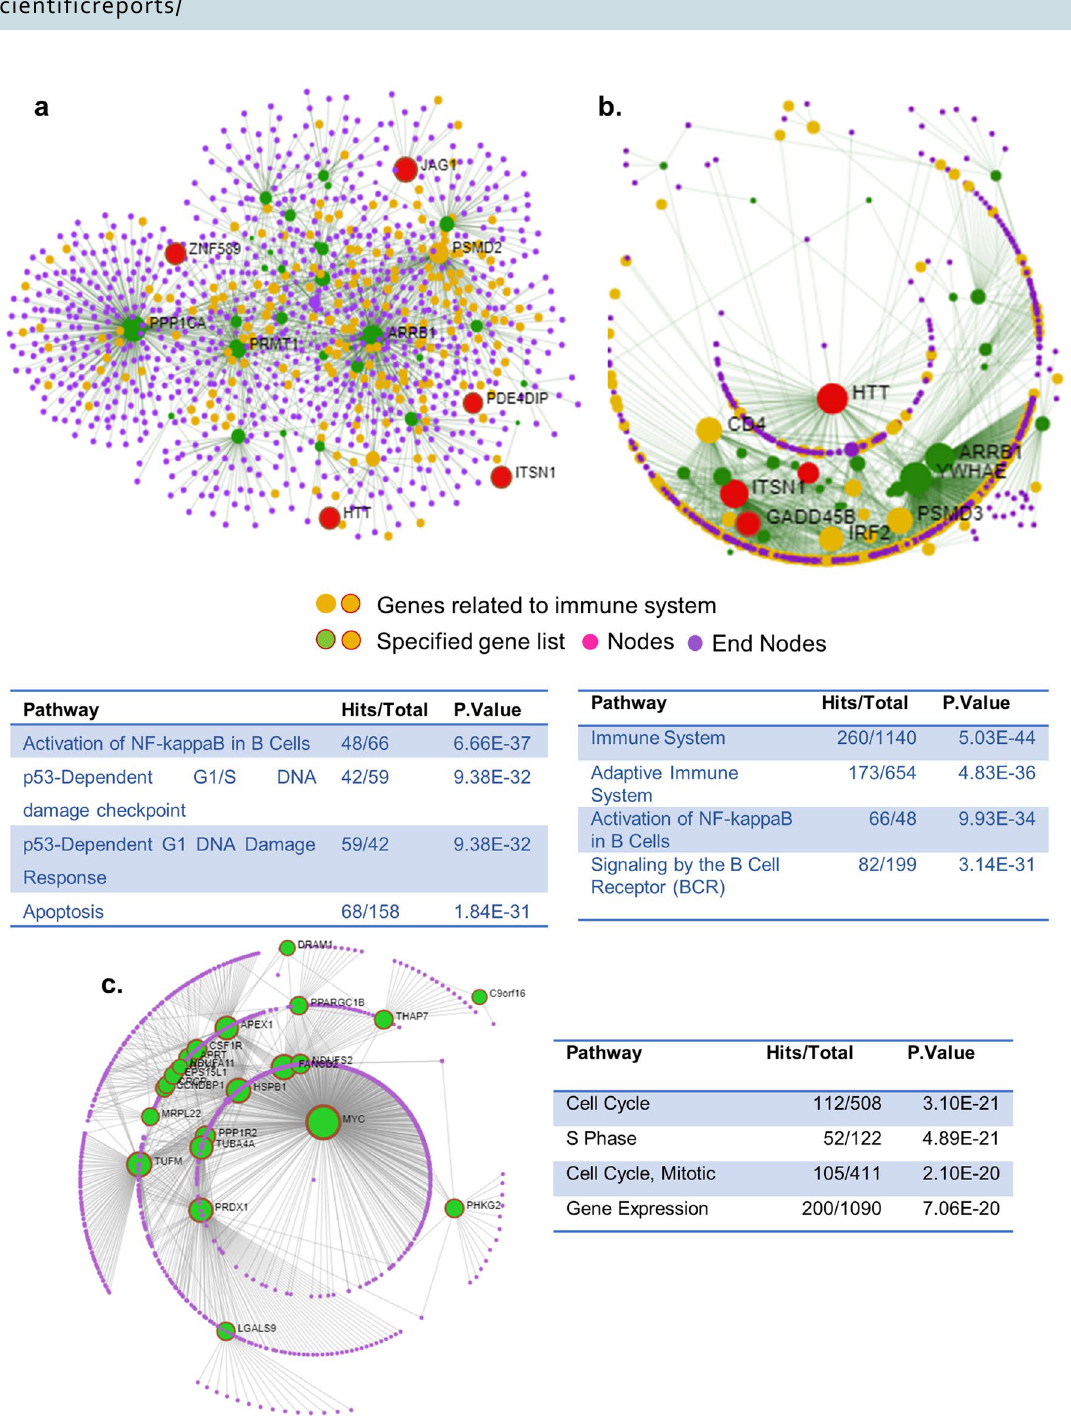
Figure 6. Protein–protein interaction network of vitamin D-modulated differentially expressed genes in SARS- CoV-2 transcriptome using Network analyst tool. ( a ) Protein–protein interaction network 40 genes shared with Vitamin D and PAK regulated genes which are down regulated in at least two SARS-COV-2 datasets were visualised. ( b ) Protein–protein interaction network of 43 genes shared among all 3 SARS-COV-2 datasets and Vitamin D regulated genes are visulaised and the genes belong to Immune system is remarked (rank 1). ( c ) Protein–protein interaction network of 24 genes shared with Vitamin D and PAK regulated genes which are up-regulated in at least two SARS-COV-2 datasets are visualised. *Results of functional enrichment analysis using Reactome is provided in the table. Pathways for the first four ranks are listed with each